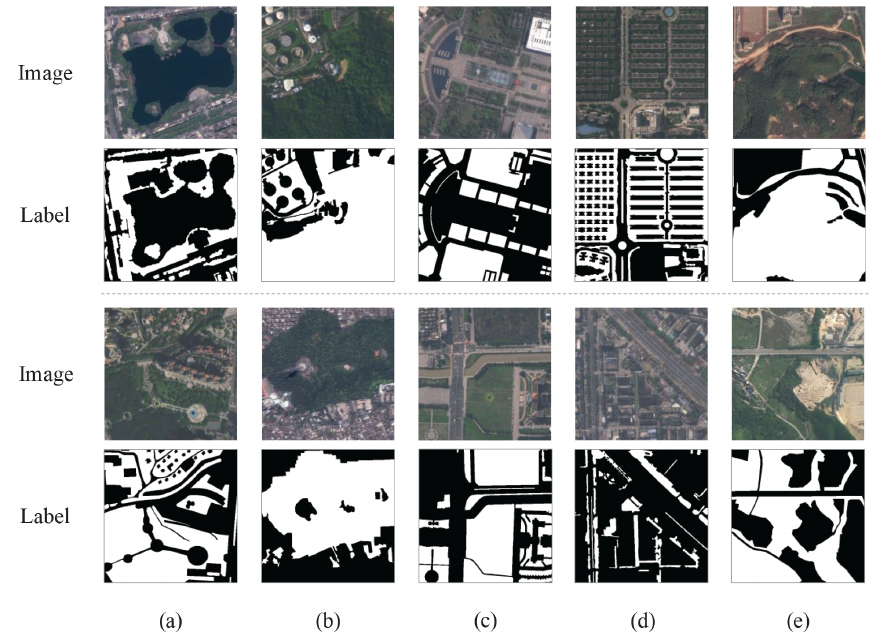
Figure 4. Example of the image–label samples in UGSet. The images were retrieved from © Gaofen-2 2019. The first and third rows denote images of the samples, while the second and fourth rows provide corresponding labels for these images. Each column shows the different UGS types of samples, including (a) parks, (b) green buffers, (c) square green spaces, (d) attached green spaces, and (e) other green spaces.